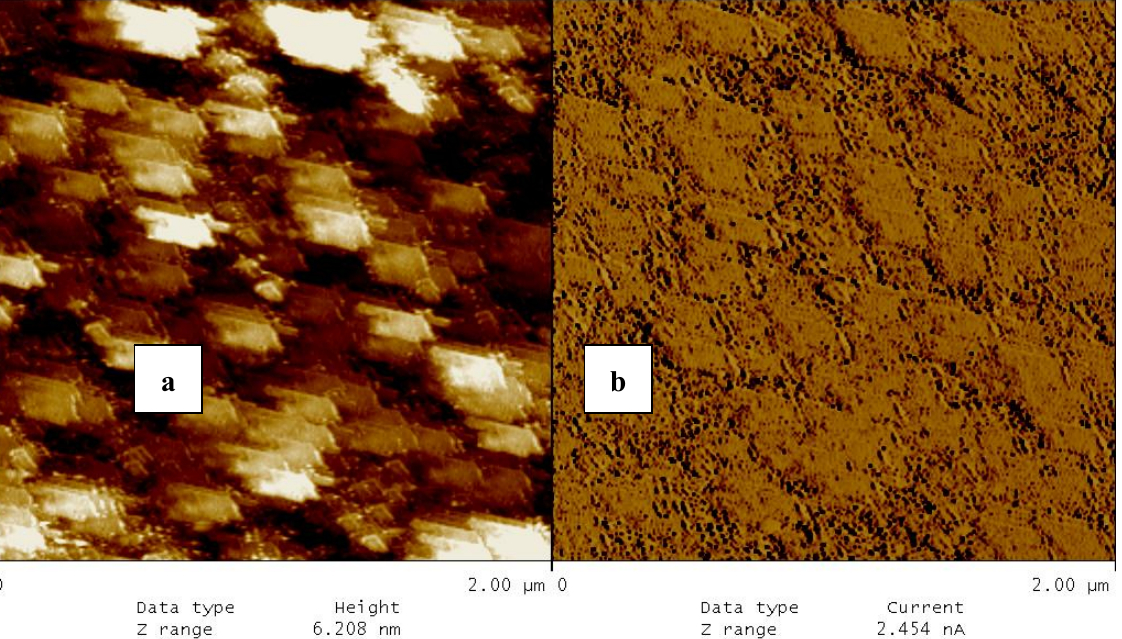
Figure 6. AFM photomicrographs of 3 –TCNQ complex LB film deposited on ITO substrates; (a) real pictures of surface topography